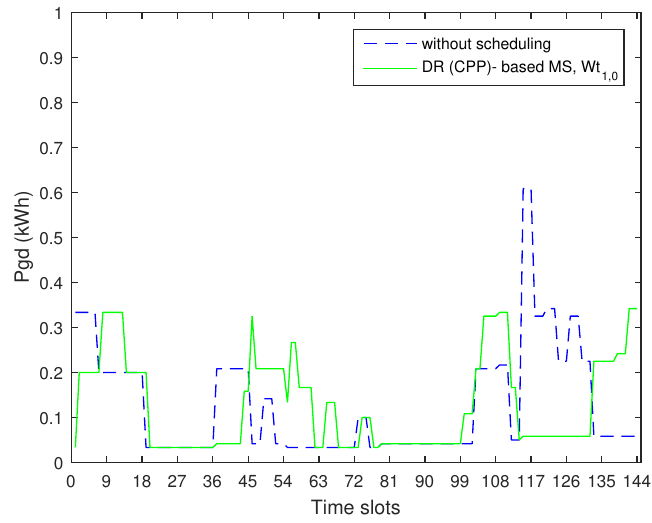
Figure 16. Load profile with maximal reduction in CE for CPP